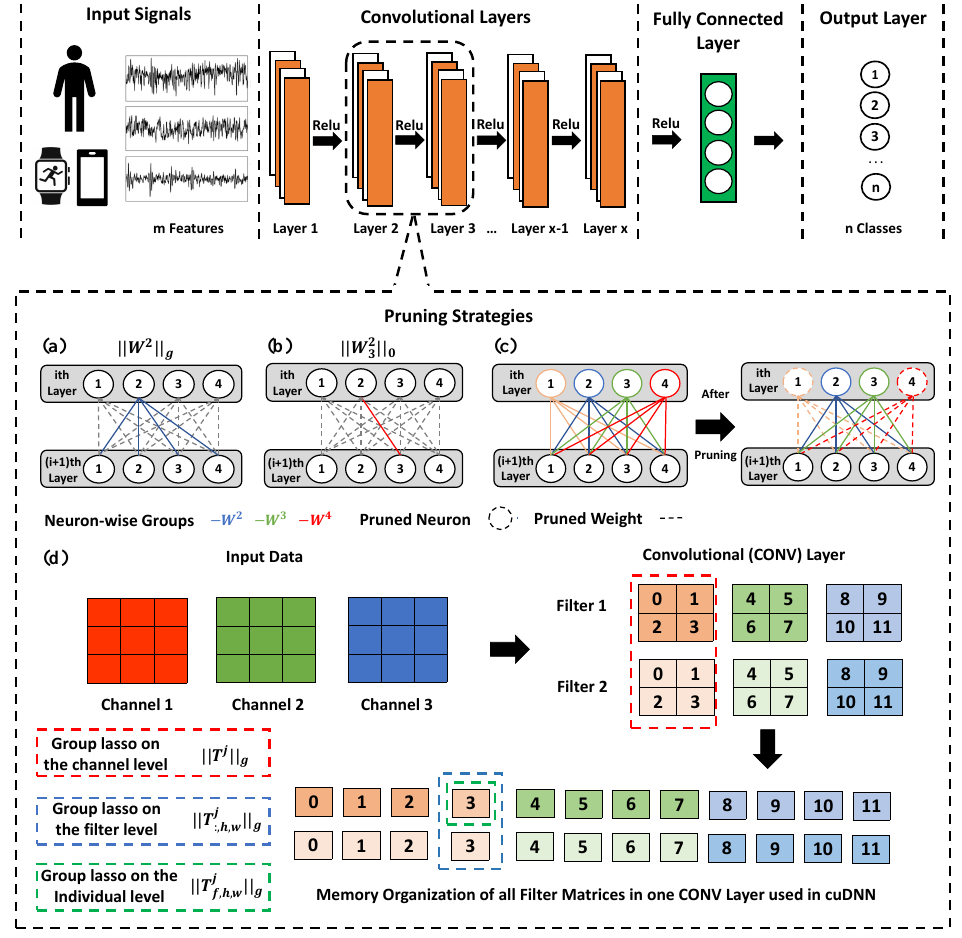
Figure 2. Overview of the proposed MobilePrune method. ( a ) Group sparsity for weights of a neuron for fully connected layers. ( b ) Sparsity on individual weights for fully connected layers. ( c ) Pruning strategy for fully connected layers and their effect where sparsity is induced on both neuron- wise groups and individual weights. ( d ) Group and individual sparsity for convolutional